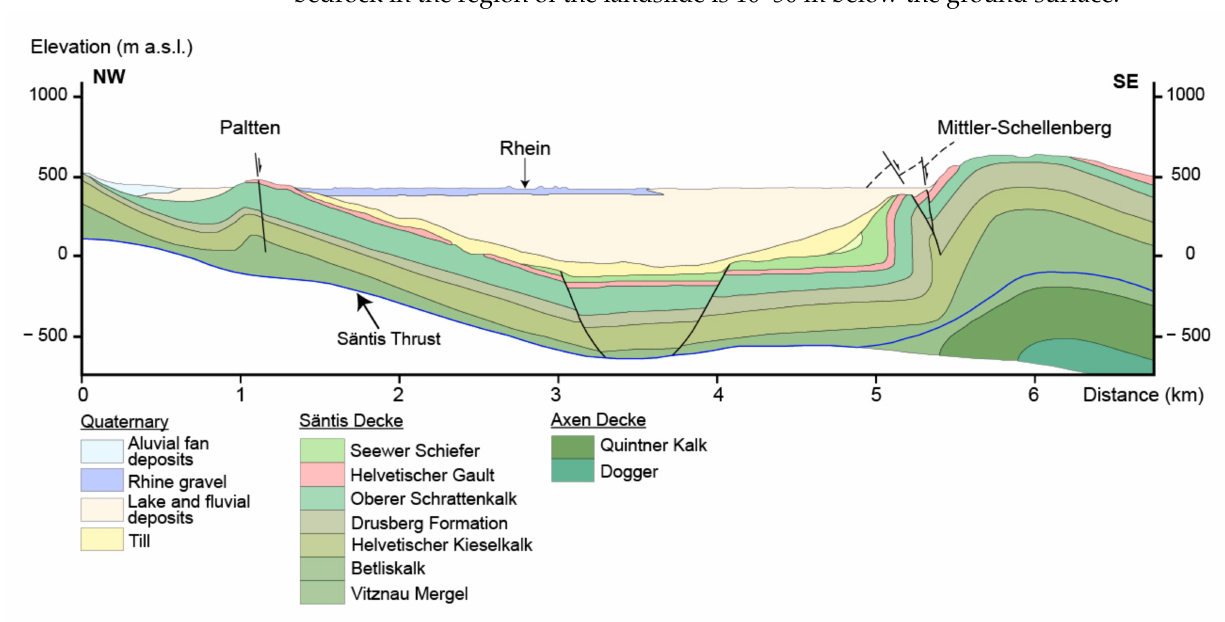
Figure 8. Säntis geological cross section—bedrock surface and Quaternary deposits boundary. Cross section line C-C (cid:48) is shown in Figure 1. Modified after